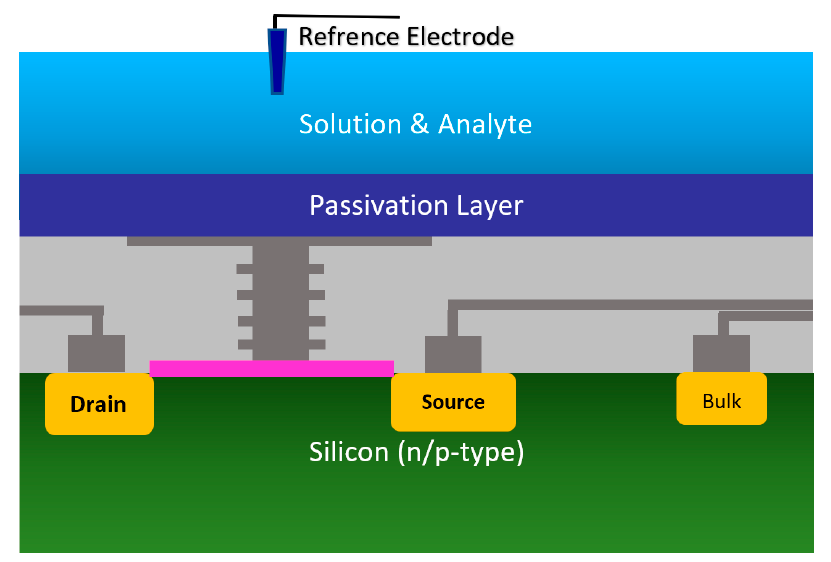
Figure 7. The standard CMOS ISFET for cellular monitoring application.